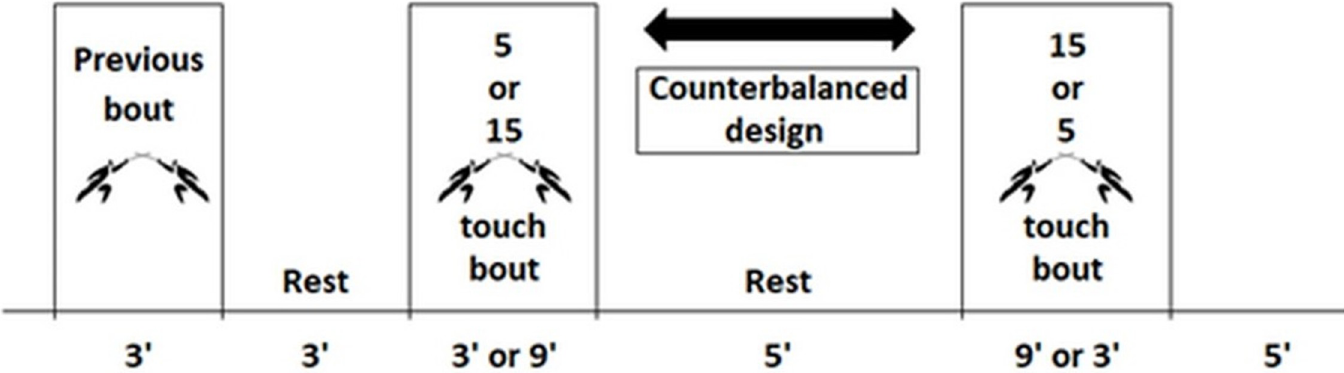
Fig 1. Counterbalanced design so that half of the fencers will start with a 5-touch round and the other half with the 15-touch round. Fight order with expired gases analysis is randomly assigned among participants.